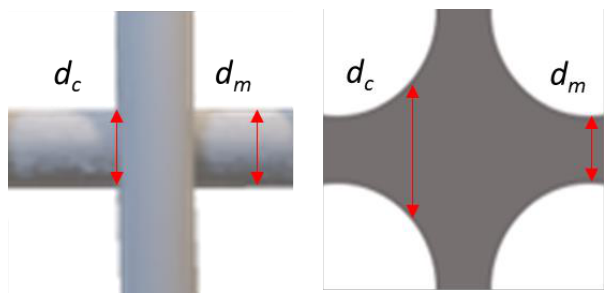
Figure 15. Schematic structure of the cross-section of two layers with high stability without any coalesce ( left ) and with poor integrity and coalesce of the strands ( middle ). Equation (4) for calculation of the U s ( right ) [36].